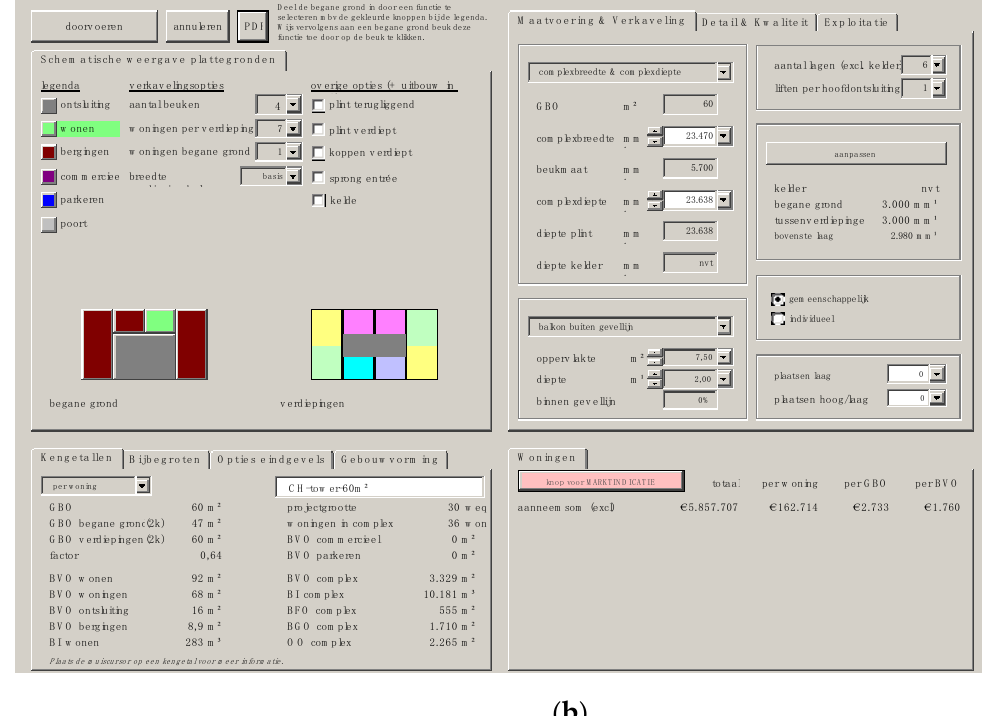
Figure 2. ( a , b ) Snapshots of the design specifications and resulting building costs for AT-MH and AT-CH, respectively.